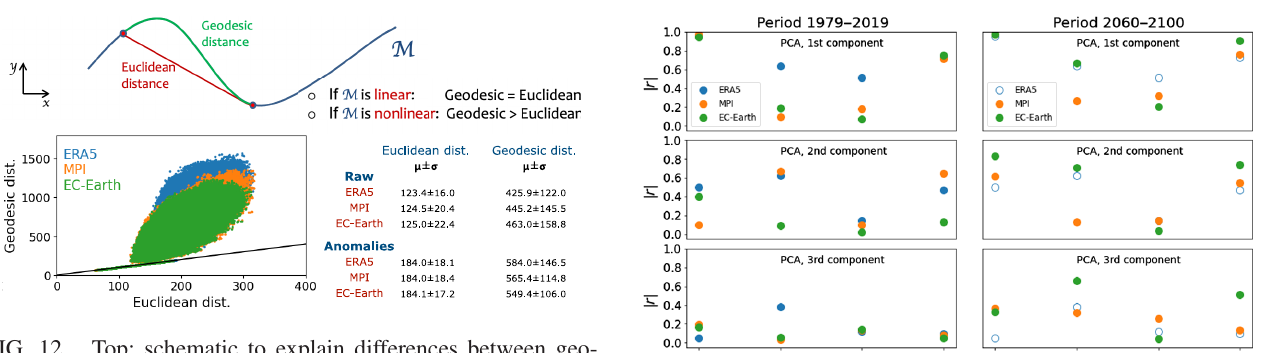
12. Top: schematic to explain differences between geo- desic ( along the manifold) and Euclidean distances. In the schematic the state space is two dimensional and the manifold M is simply a line. Bottom: geodesic ( along the manifold) and Euclidean distances between each pair of points in each dataset for anomalies (no seasonality and no trends) in the period 1979 – 2019. Points are above the diagonal, therefore quantifying the intrinsic nonlinearity of the low-dimensional manifold. Distances are computed in the full 17 092-dimensional state space. Mean μ and standard deviation σ for all three datasets are reported in the case of raw and anomalies. Raw data include